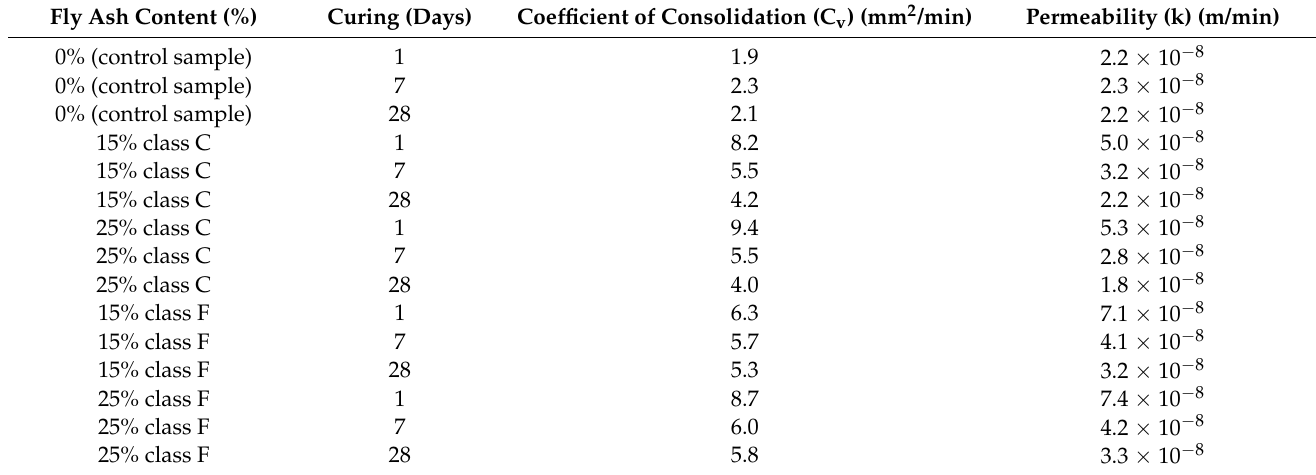
Table 6. Effects of fly ash and curing time on coefficient of consolidation and